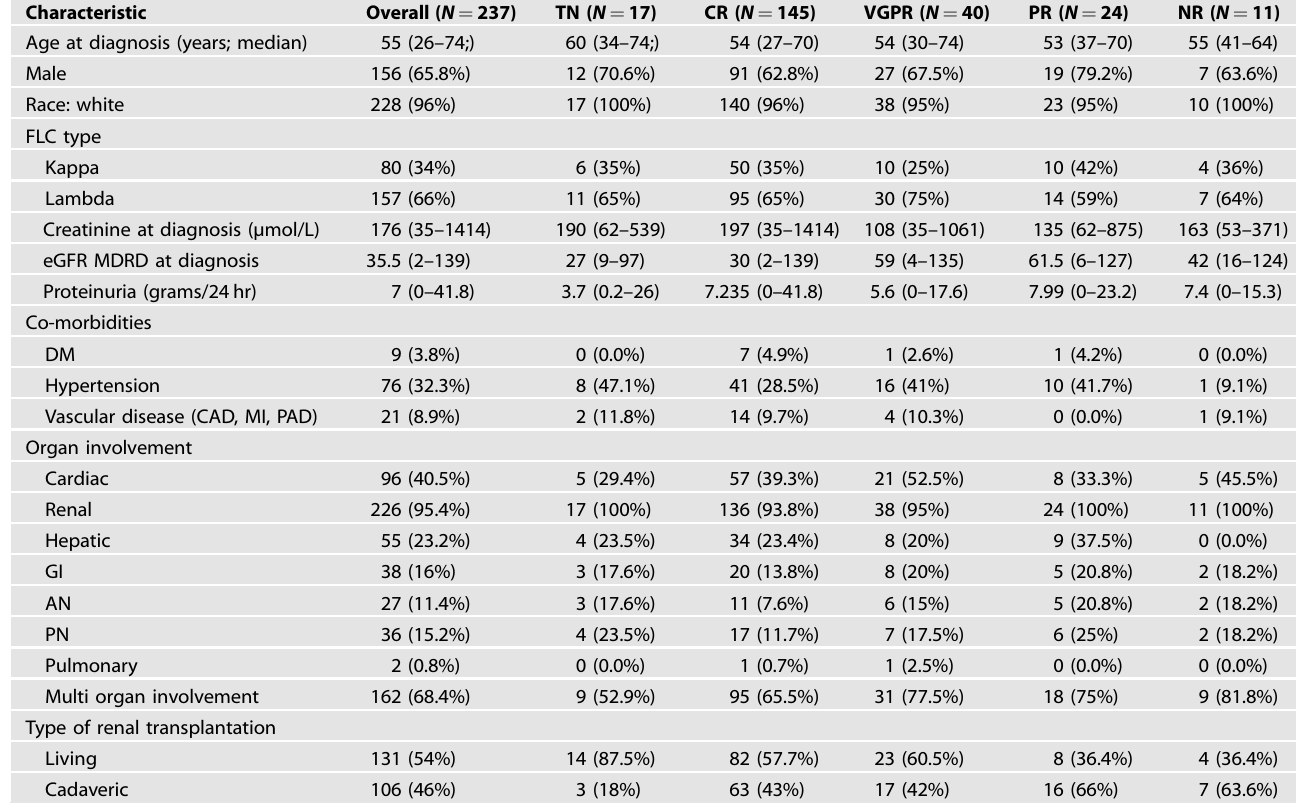
Table 1. Baseline patient characteristics according to hematologic response status at the time of kidney transplantation.